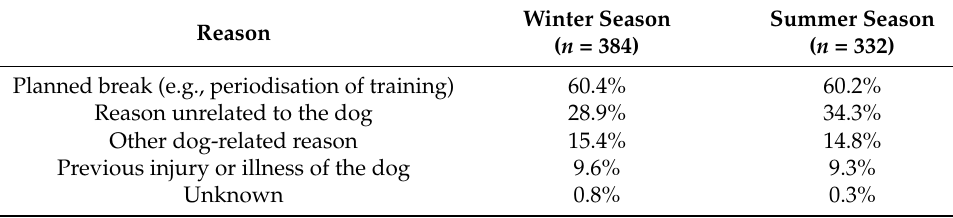
Table 4. Reasons for time off from